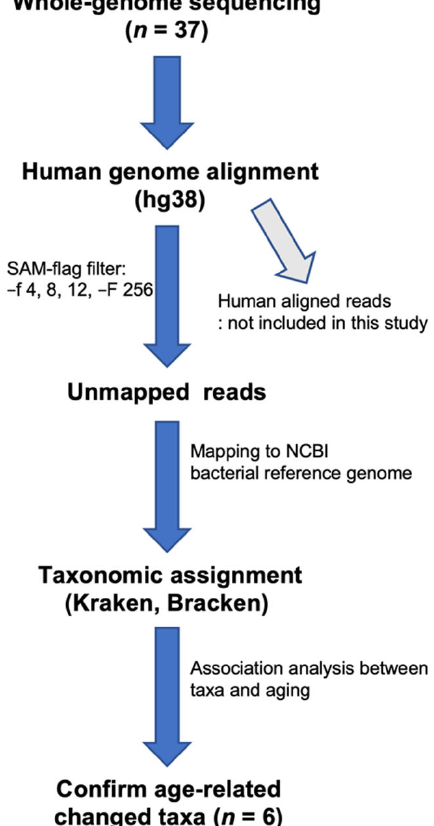
Figure 1. Workflow of the human DNA filtering and bacterial identification procedure. Reads that mapped to the human reference genome sequence or aligned with human sequences in the nt database were removed. The taxonomic classification of the reads was performed using Kraken and Bracken, with the help of a microbial genome database.